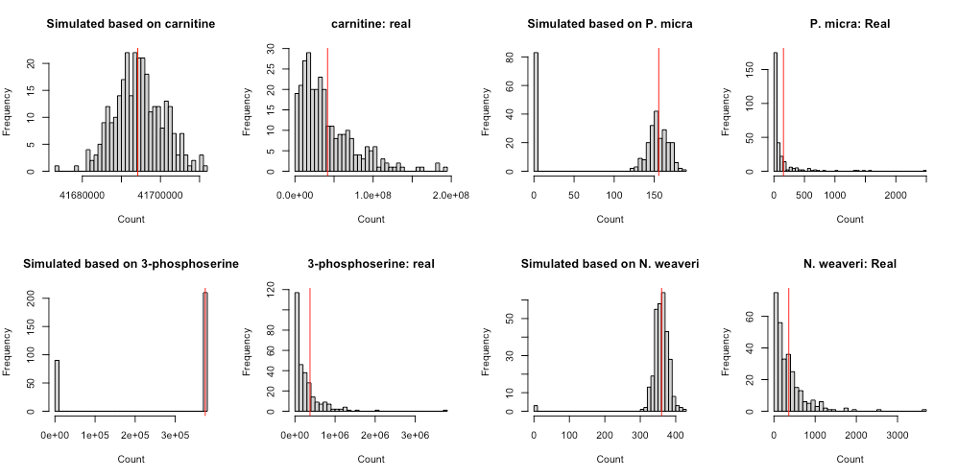
Figure A2. Comparison of simulated counts drawn from (ZI-)Poisson distribution (with parameters from model fitted on the real data) and real data of 4 randomly-selected metabolites and species. The red vertical line on each plot represents the Poisson model-based mean of the nonzero component for each metabolite and species.